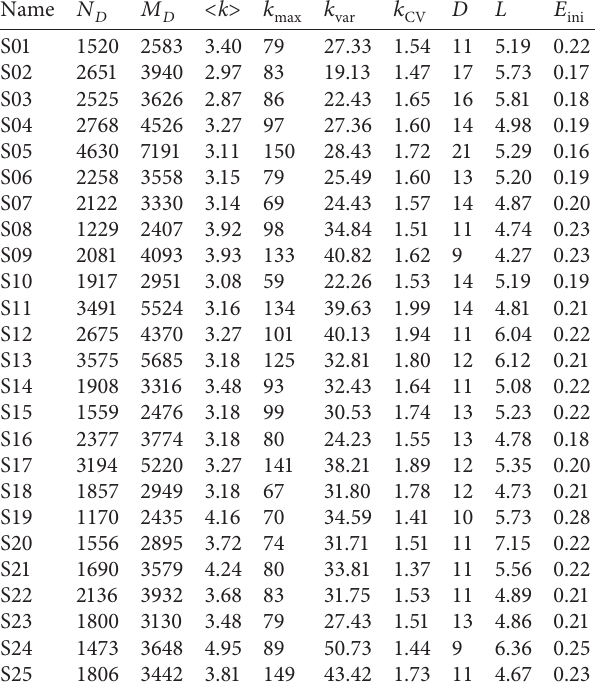
Table 2: Basic network properties and statistics of the 25 urban road networks measured in the dual mapping